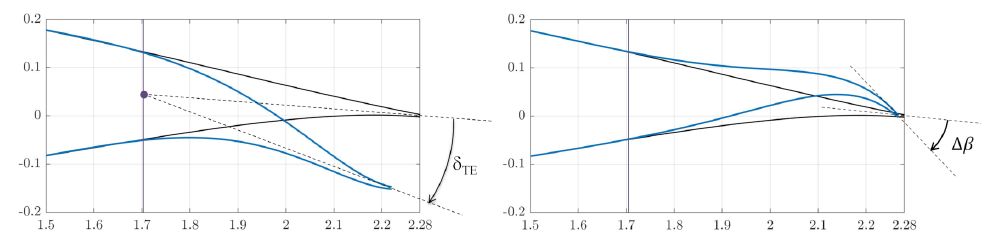
Figure 5. Morphing shape optimization variables: trailing-edge equivalent rotation ( left ) and tail- angle variation ( right